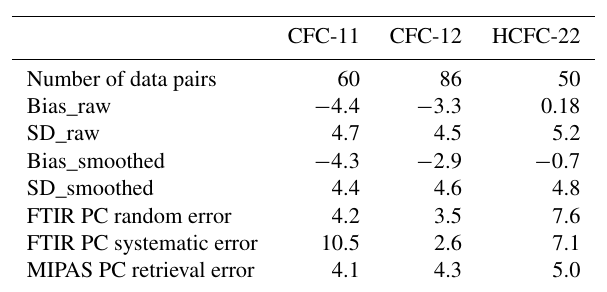
Table 4. The number of collocated MIPAS-FTIR pairs, bias and standard deviation (SD) of the relative differences ((MI- PAS − FTIR) / FTIR × 100%) between the partial columns (6– 30km) of MIPAS (both the raw and smoothed data) and FTIR, to- gether with the mean random and systematic uncertainties of the FTIR partial columns and the retrieval error of the MIPAS data (in %).